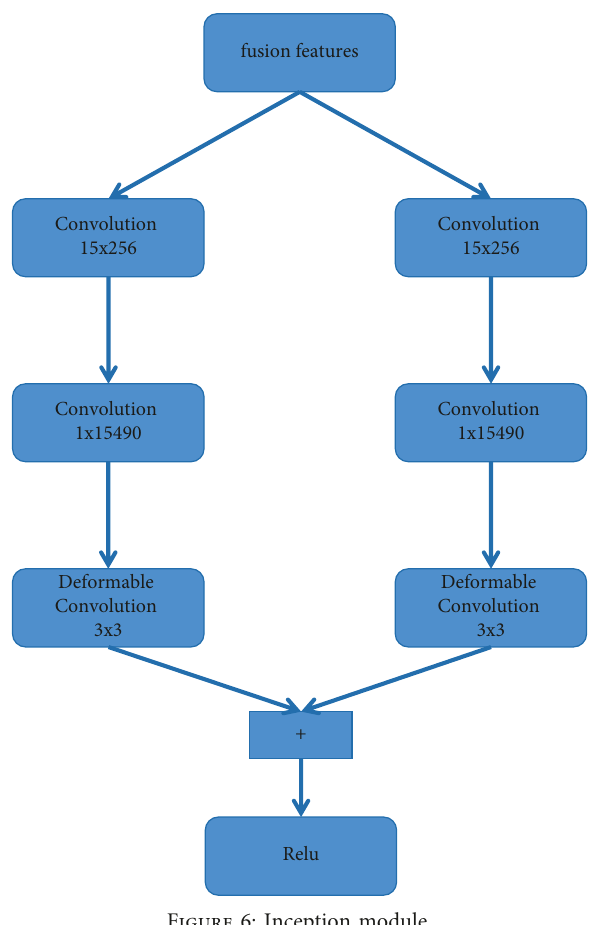
Figure 6: Inception